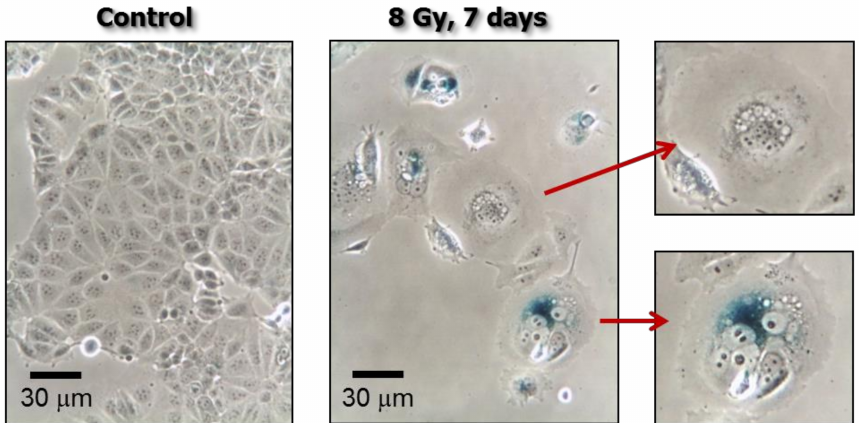
Figure 2. Phase-contrast photomicrographs showing stress-induced premature senescence (SIPS) in MDD2, a mutant p53-expressing derivative of the MCF7 breast carcinoma cell line [19]. Cultures were exposed to ionizing radiation (8 Gy) or sham-irradiated (control), incubated for seven days, and evaluated for flattened and enlarged cellular morphology and positive (blue) staining in the senescence-associated β -galactosidase